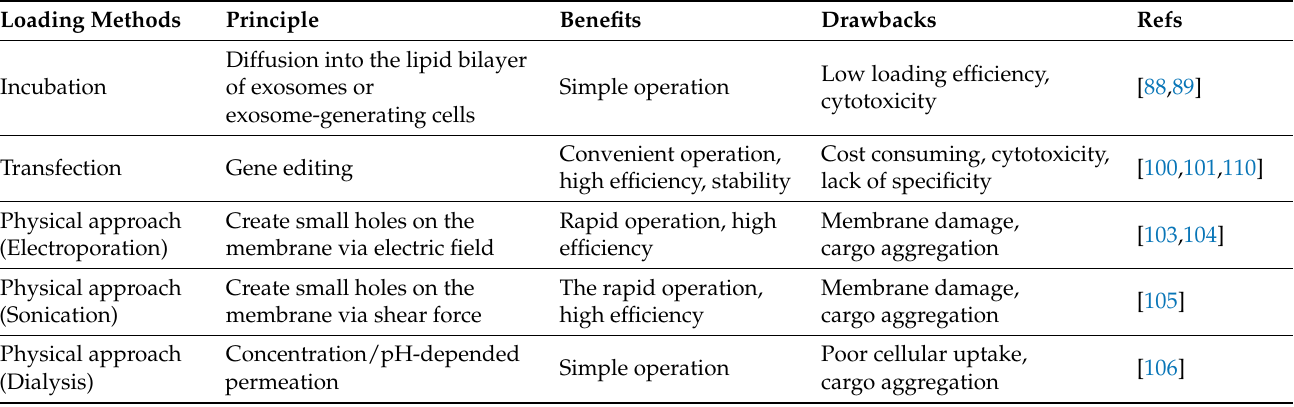
Table 2. Methods of RNA